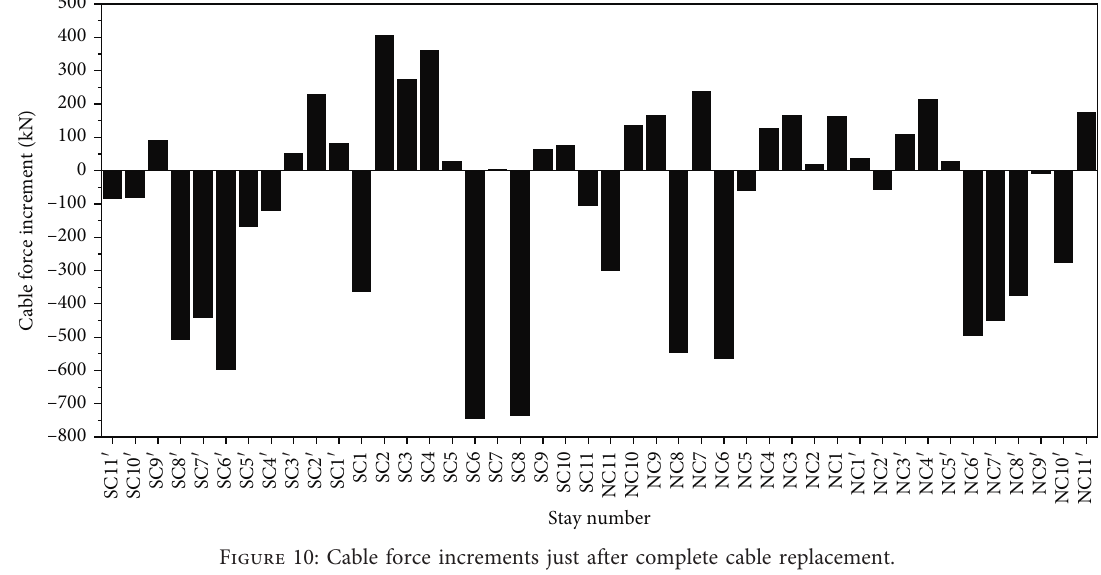
Figure 10: Cable force increments just after complete cable replacement.